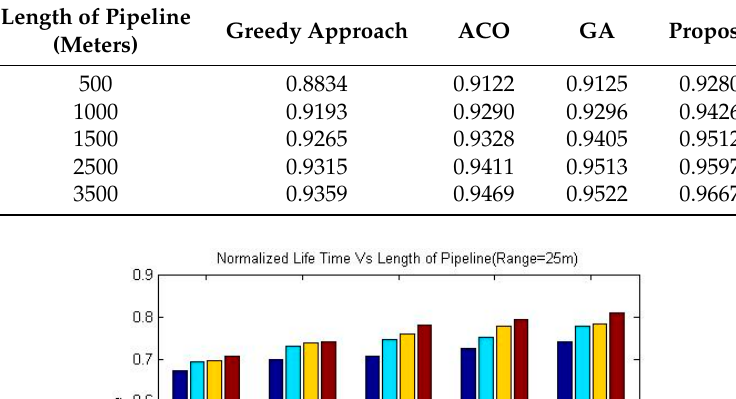
Table 10. Comparison of Normalized Life Time (Range 100 m).